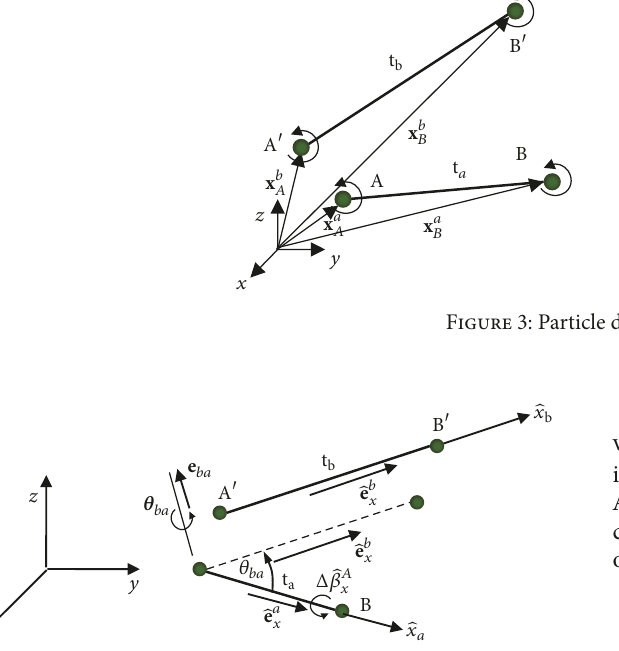
Figure 4: Rotational angle of space beam element in principal axis direction.